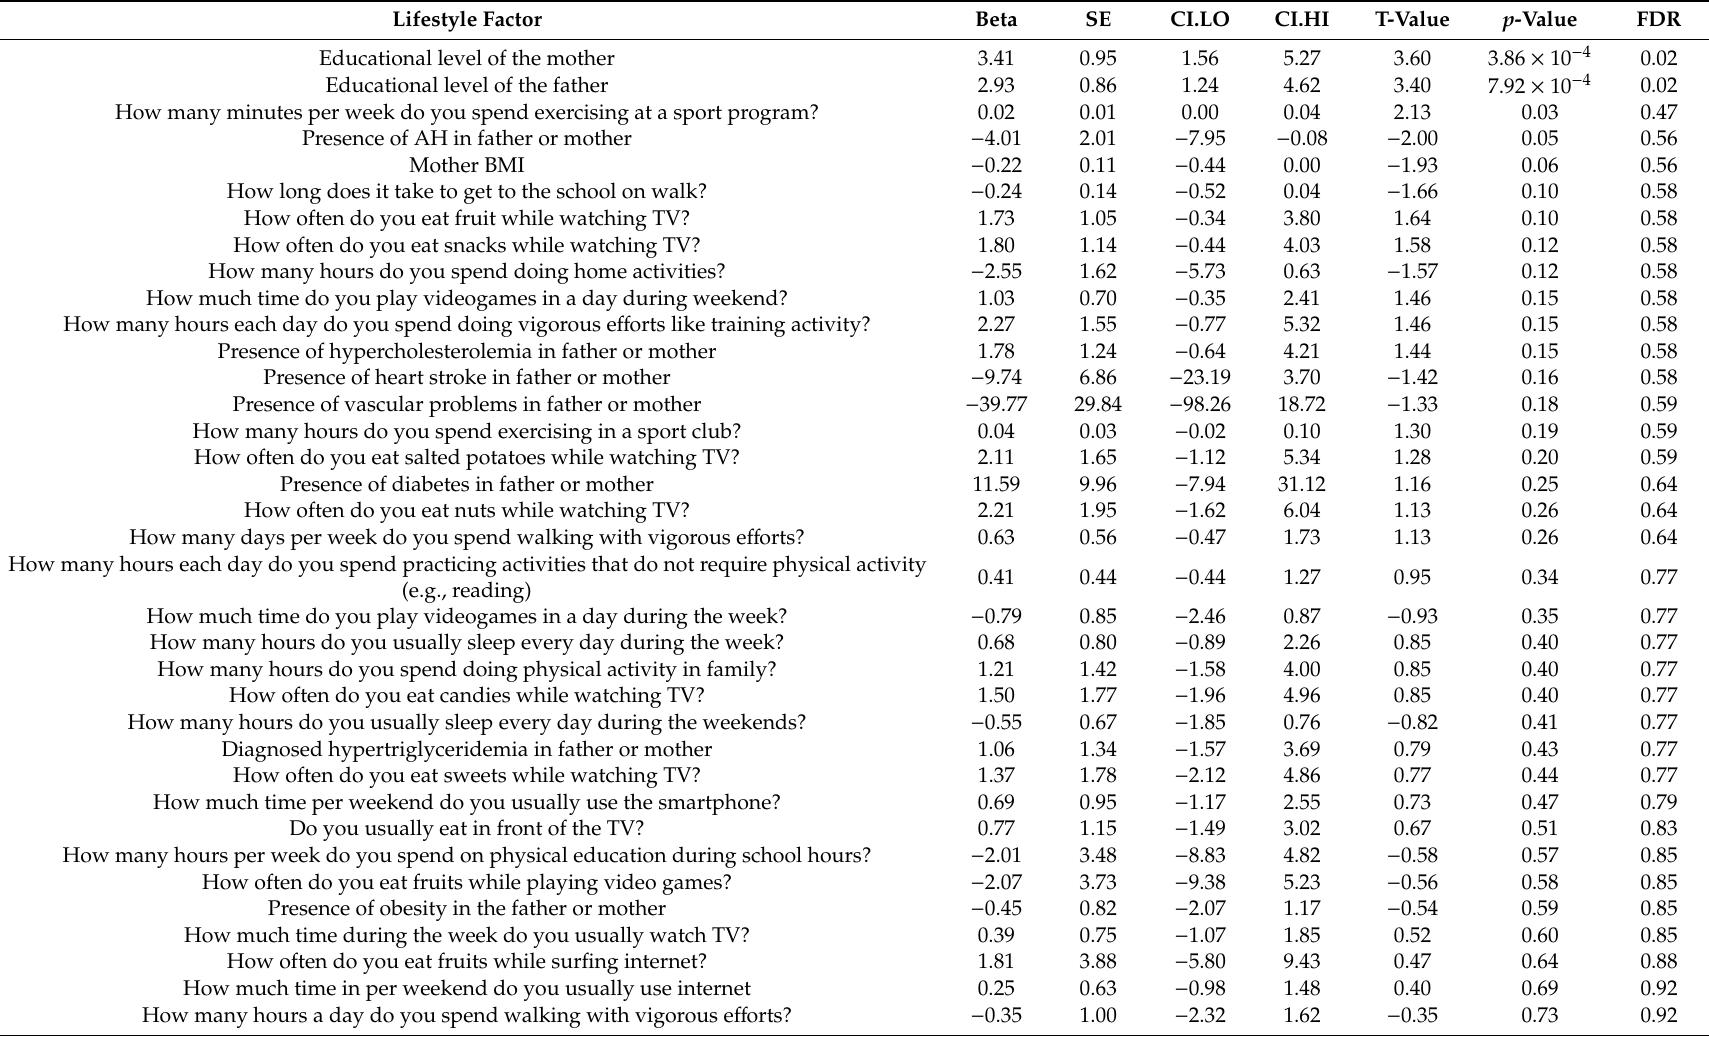
Table 4. Interaction analyses between the pGRS and each assessed environmental factor in the study population